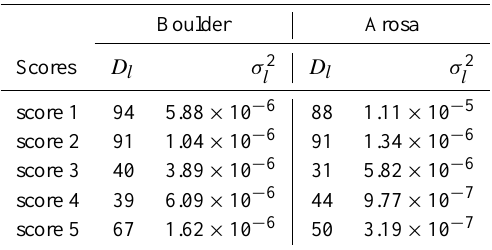
Fig. 9. Monthly contribution of AO to changes in ozone profiles for selected altitudes (indicated on top of each plot with station). The contribution (%) is obtained as monthly data, but we group them by years to remove seasonal variability. The contributions (%) are grouped by year and displayed as box plots. Table 3. Explained deviance D l (%) in Eq. (11) and the estimates of the noise levels σ l in Eq. (9). Explained deviance indicates overall quality of model